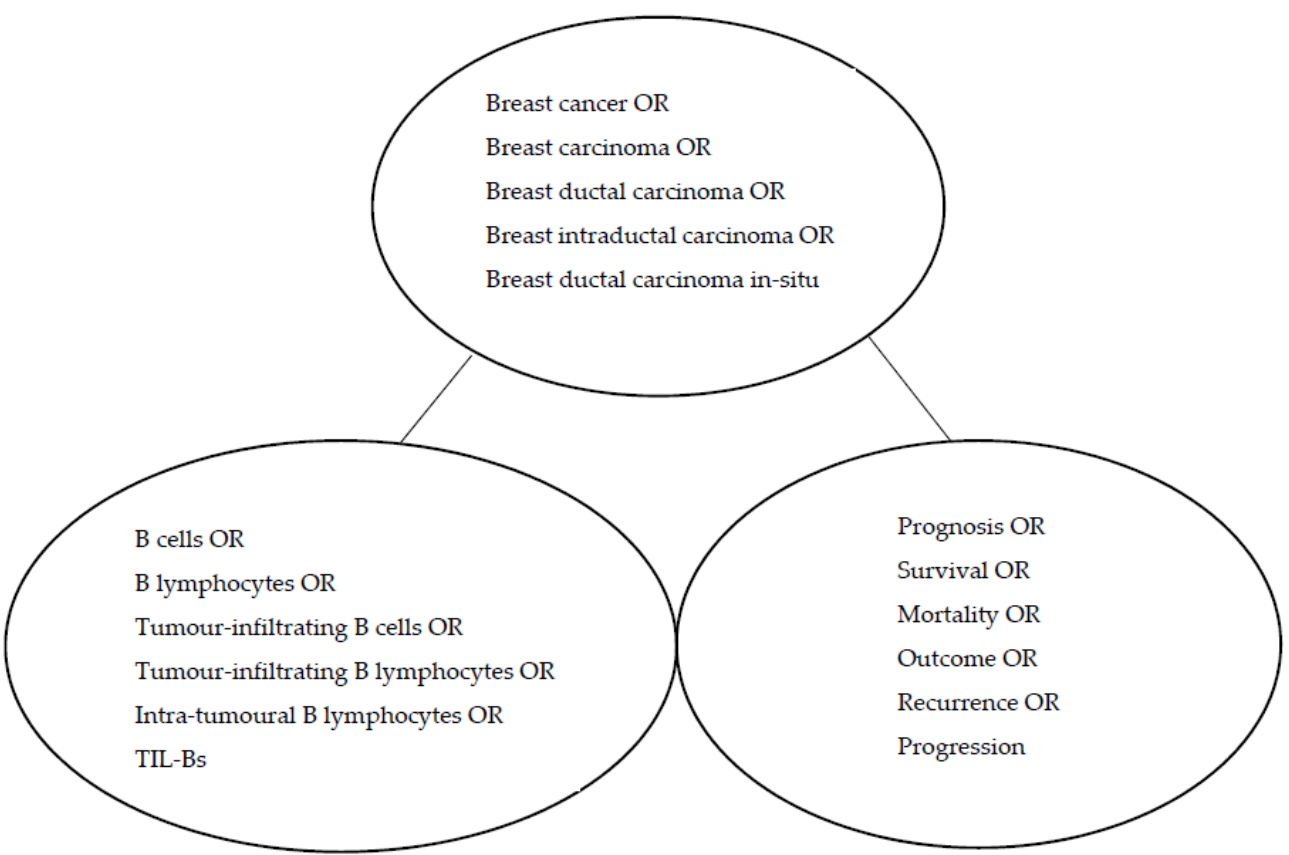
Figure 1. Boolean search with keywords and their synonyms.